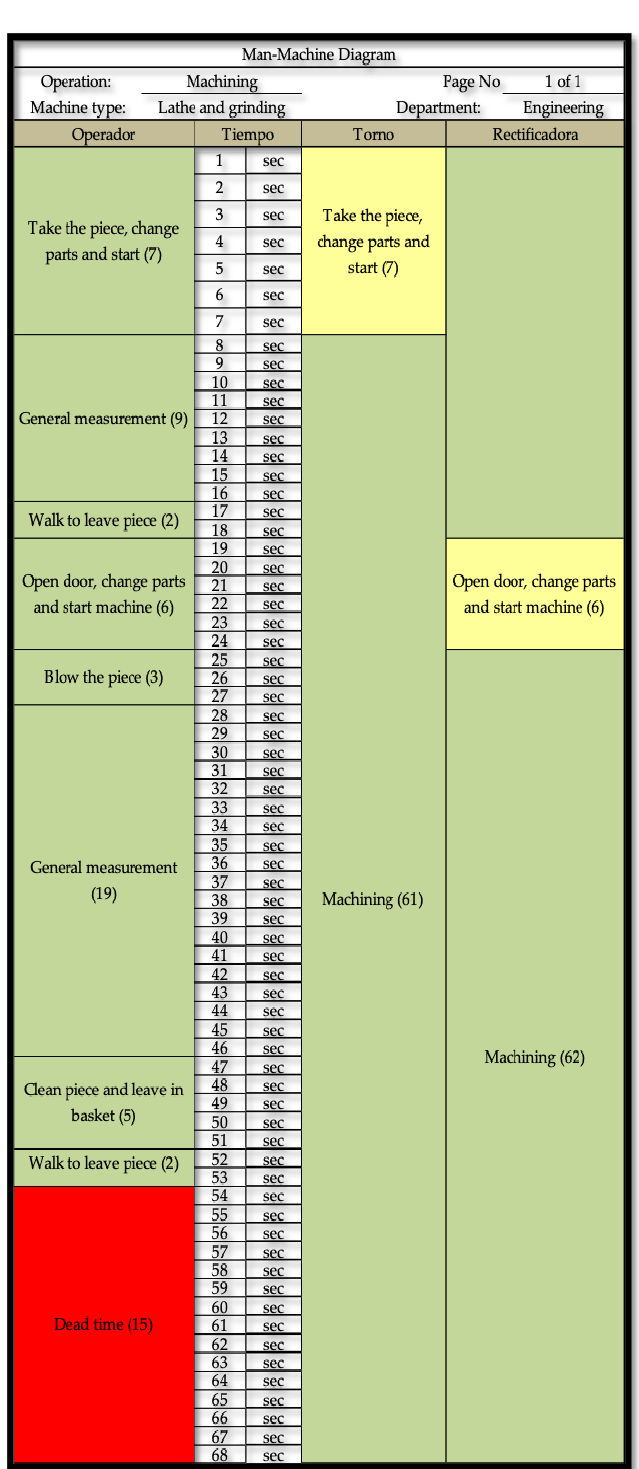
Table 4. Man-machine diagram of the lathe process and grinding